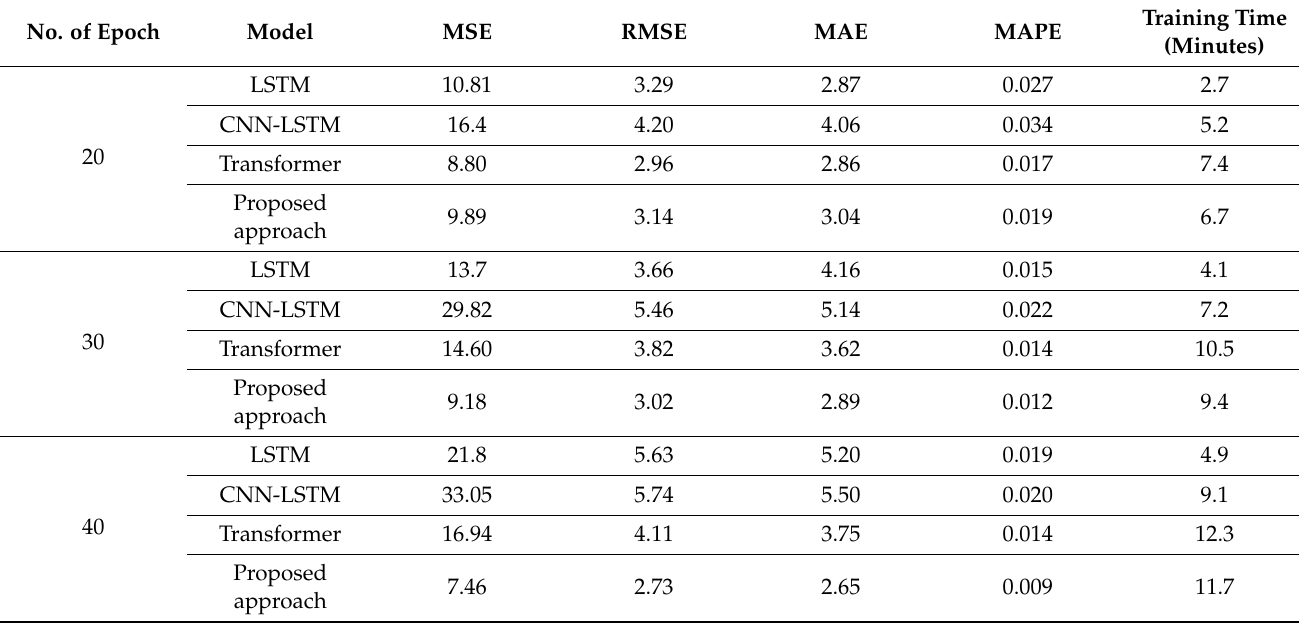
Table 2. The 5 min ahead forecasting performance of LSTM, CNN-LSTM, Transformer models, and our proposed approach (Single- Dense Layer BiLSTM).